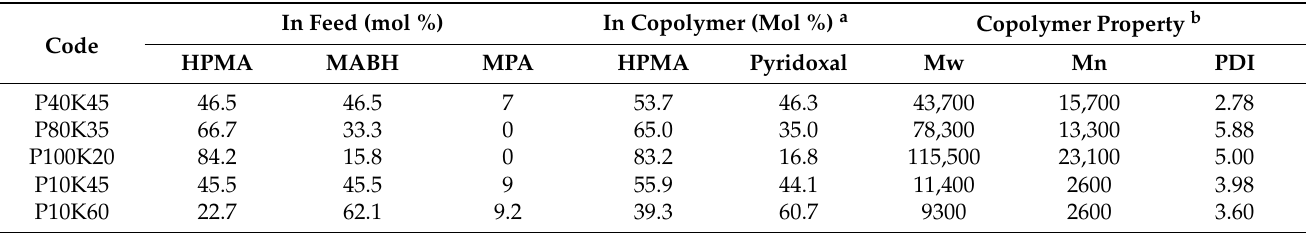
Table 1. The composition of P(HPMA- co -MA- hyd -VB6)